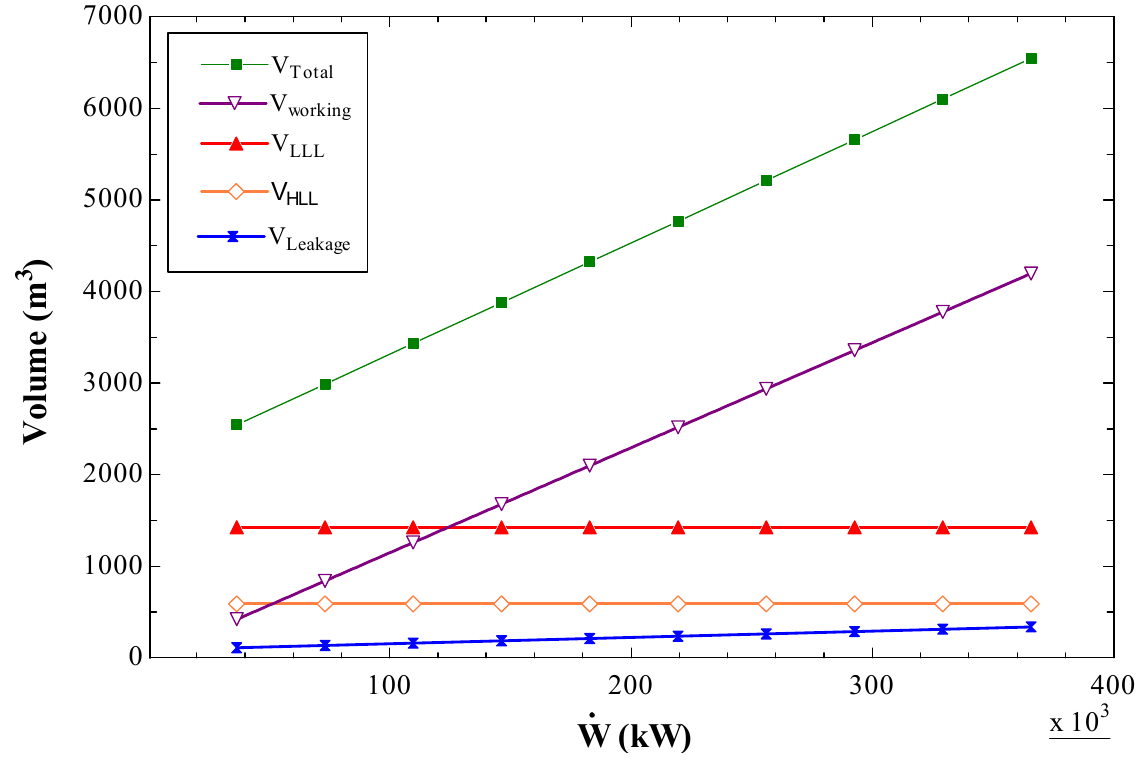
Figure 9. The Cryogenic tank capacity calculation per power production .